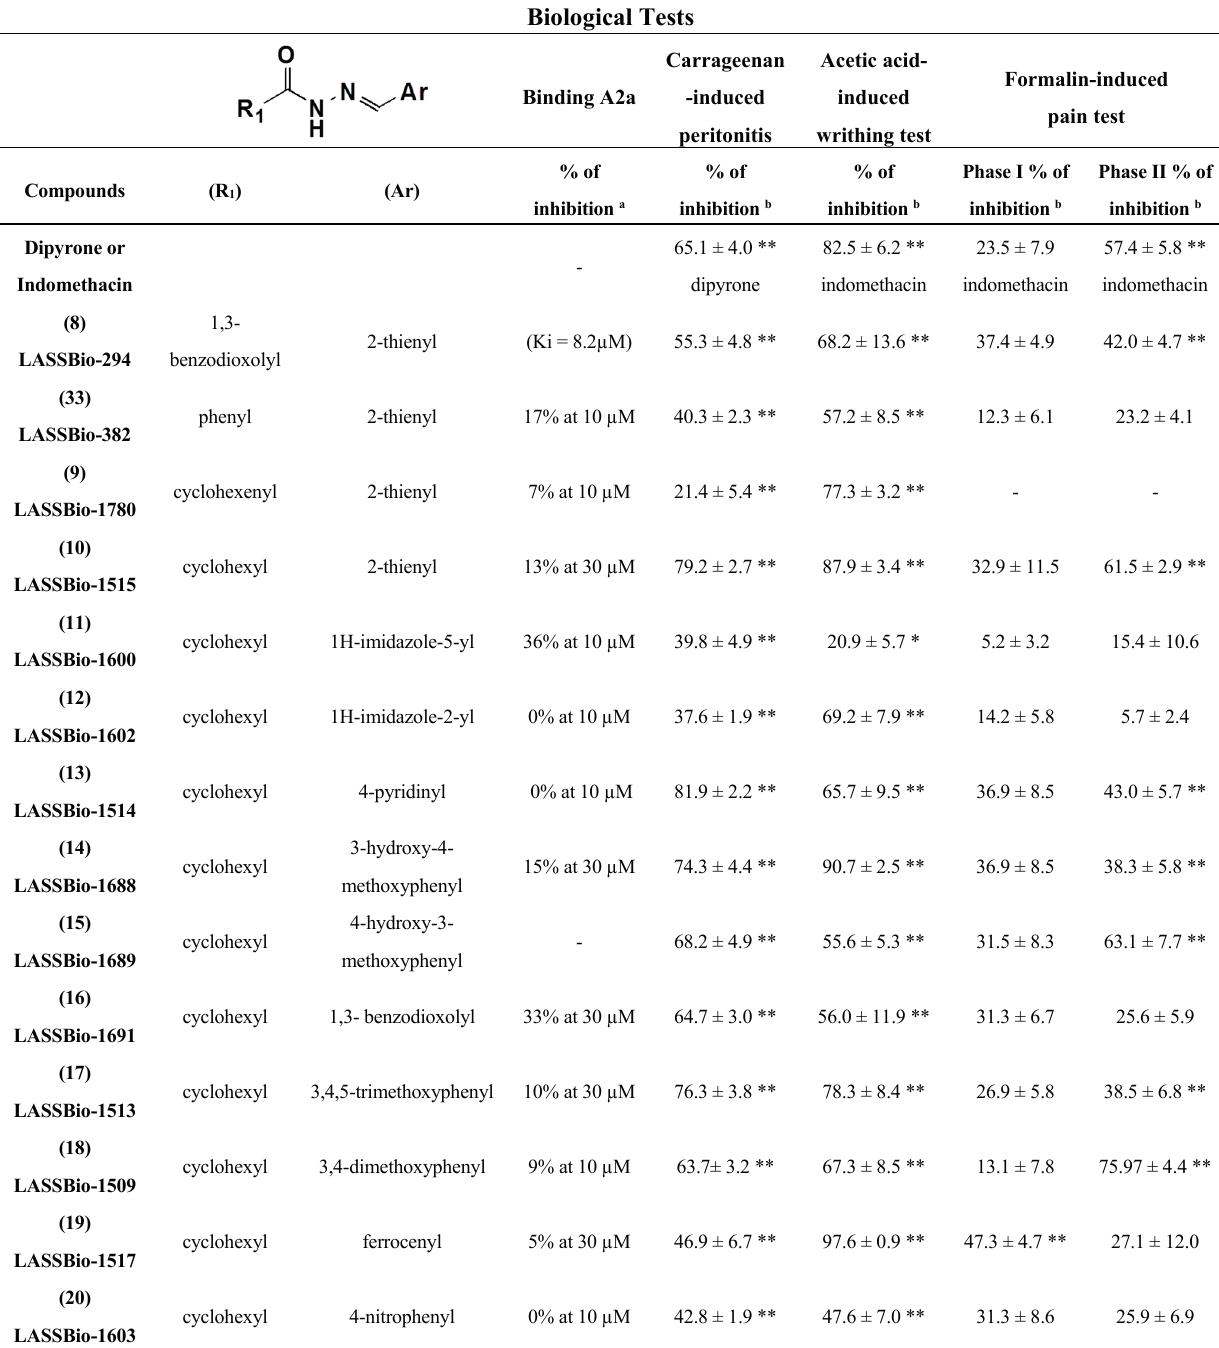
Table 1. Effect of N -acylhydrazones (10 or 30 µM in binding assay and 100 µmol/kg p.o. in the in vivo assays), dipyrone or indomethacin (100 µmol/kg, p.o in vivo